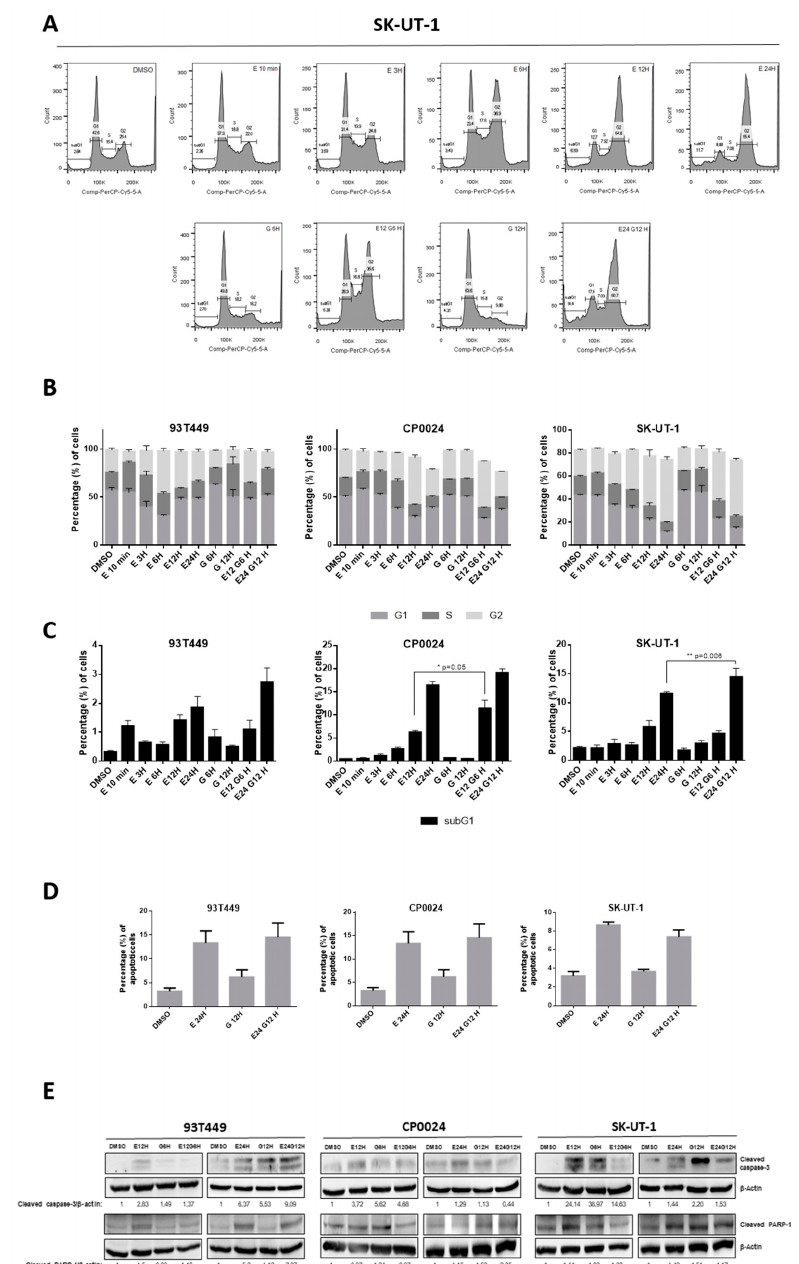
Figure 2. Study of changes in cell cycle and apoptosis after treatment with eribulin and gemcitabine . ( A ) Example of cell cycle profiles in the SK-UT-1 line after treatment with eribulin (1 nM) and